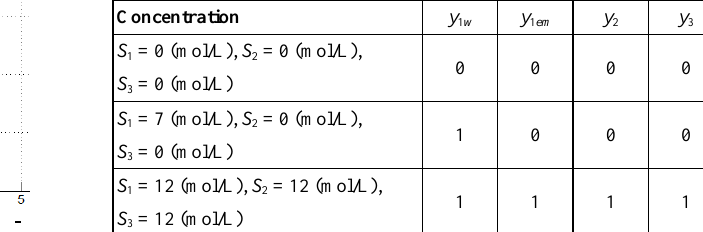
output signals stay at “0”